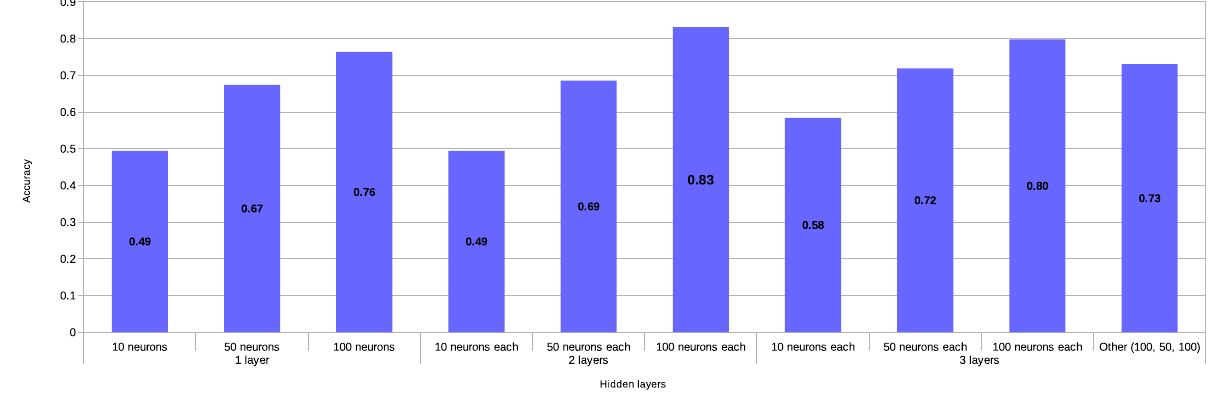
Figure 7. Classification model for primal method—tuning the number of hidden layers and neurons ( tanh activation function, lbfgs solver).